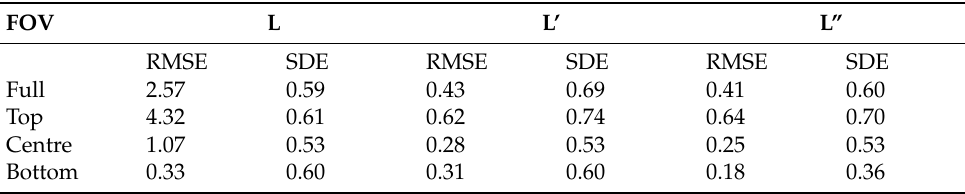
Figure 11. Mean absolute error (MAE) with standard deviation in measured and corrected length. Table 1. Root mean square error (RMSE) and standard deviation (SDE) for length estimation methods and selected field of view